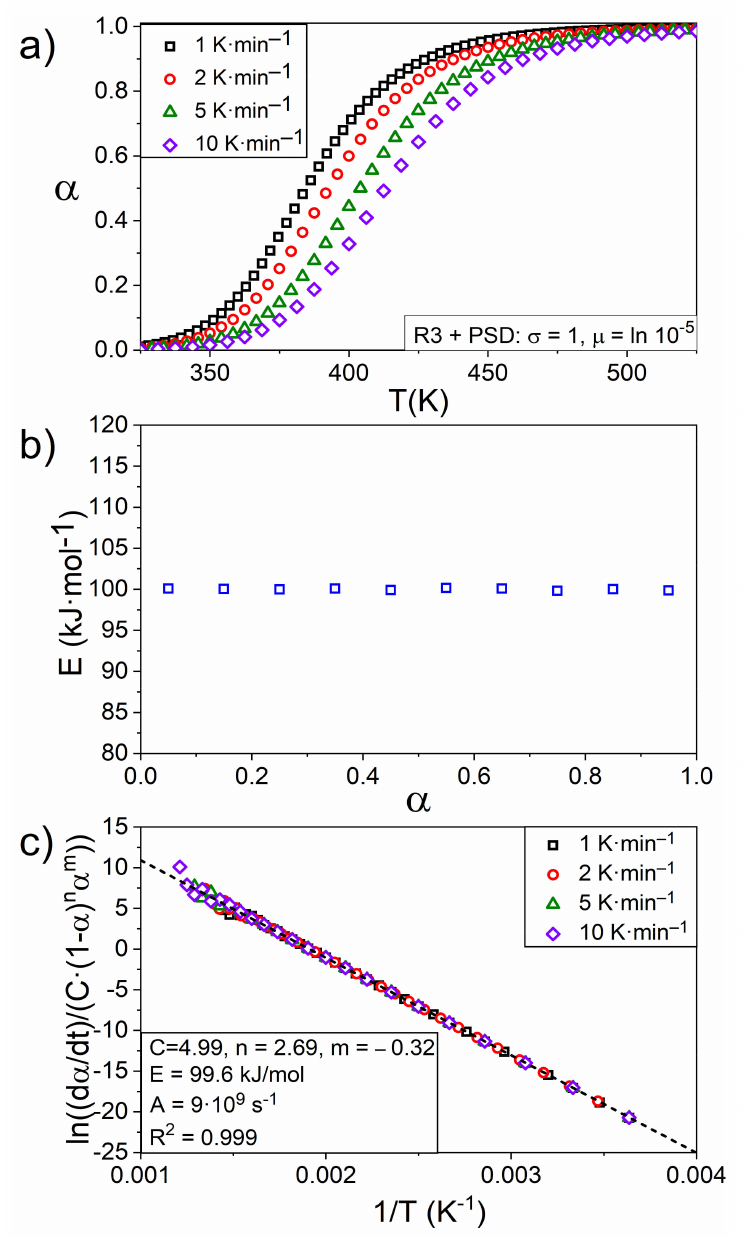
Figure 3. ( a ) Curves simulated under linear heating conditions using the kinetic model R3 with the PSD shown in Figure 1b. ( b ) Values of activation energy as a function of the fractional reaction obtained by the Friedman isoconversional method. ( c ) Combined kinetic